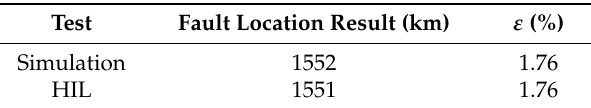
Table 7. Location results of ABG fault.